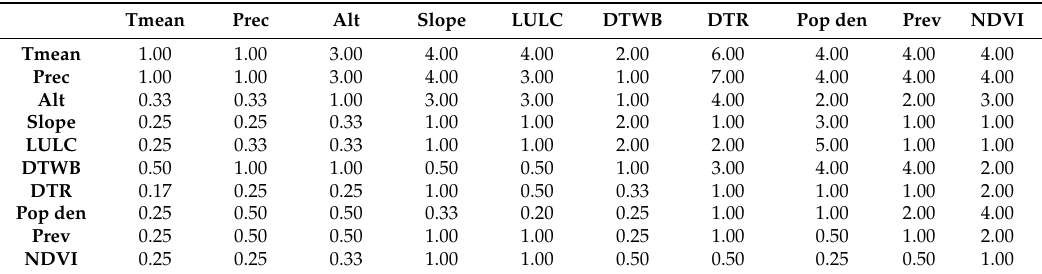
Table 3. 10 × 10 Comparison Matrix of the Risk Factors used in the study.